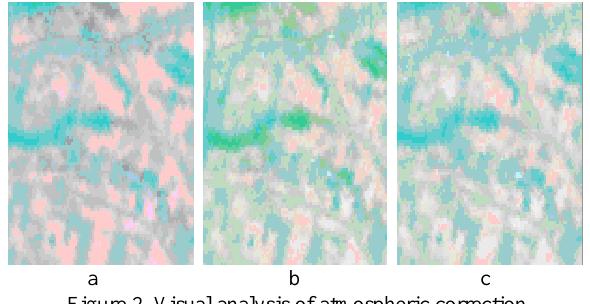
Figure 2. Visual analysis of atmospheric